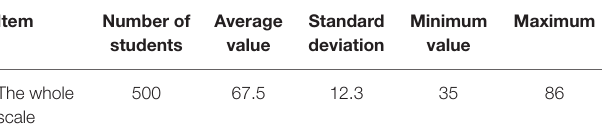
TABLE 2 | Statistical results of the overall scale.